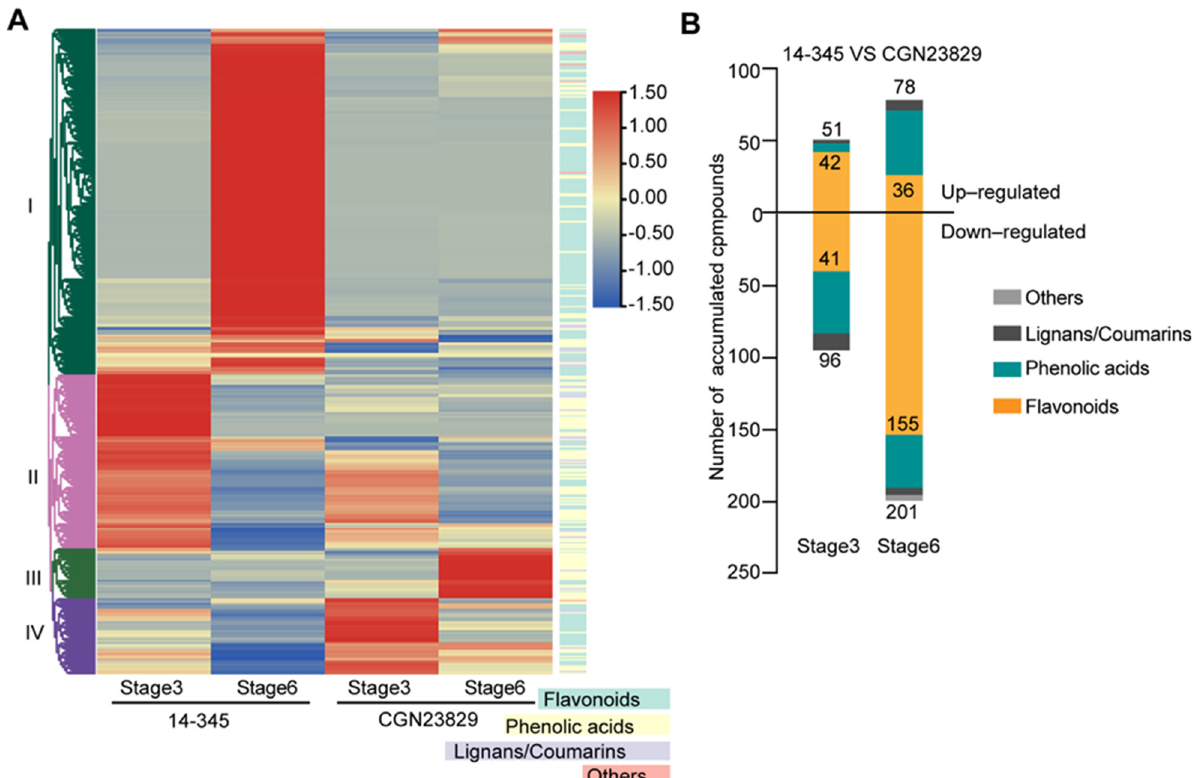
Figure 2. Overview of phenylpropanoid metabolite profiling in the fruit peel of ‘14-345’ and ‘CGN23829’. ( A ) Hierarchical cluster analysis of all the compounds detected in this study; ( B ) differentially accumulated metabolites at the two stages.